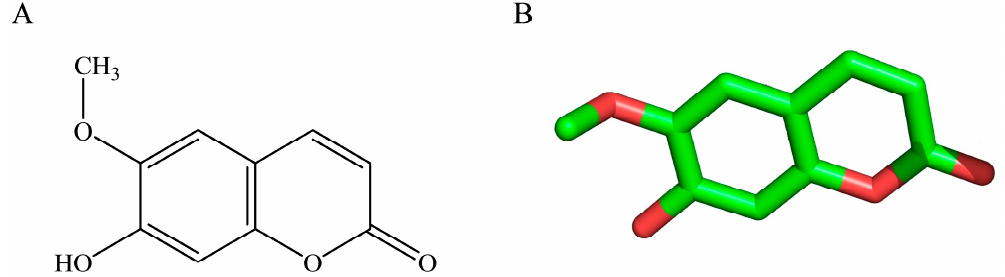
Figure 7. ( A ) Chemical structural formula and ( B ) the cartoon representation of scopoletin. Red regions represent oxygen atoms; green regions represent carbon atoms.